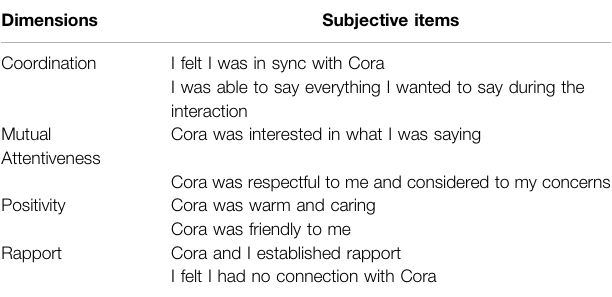
TABLE 1 | Subjective questionnaire adapted from (Zhaoet al., 2018a) to measure users ’ perceived quality of the interaction. Dimensions